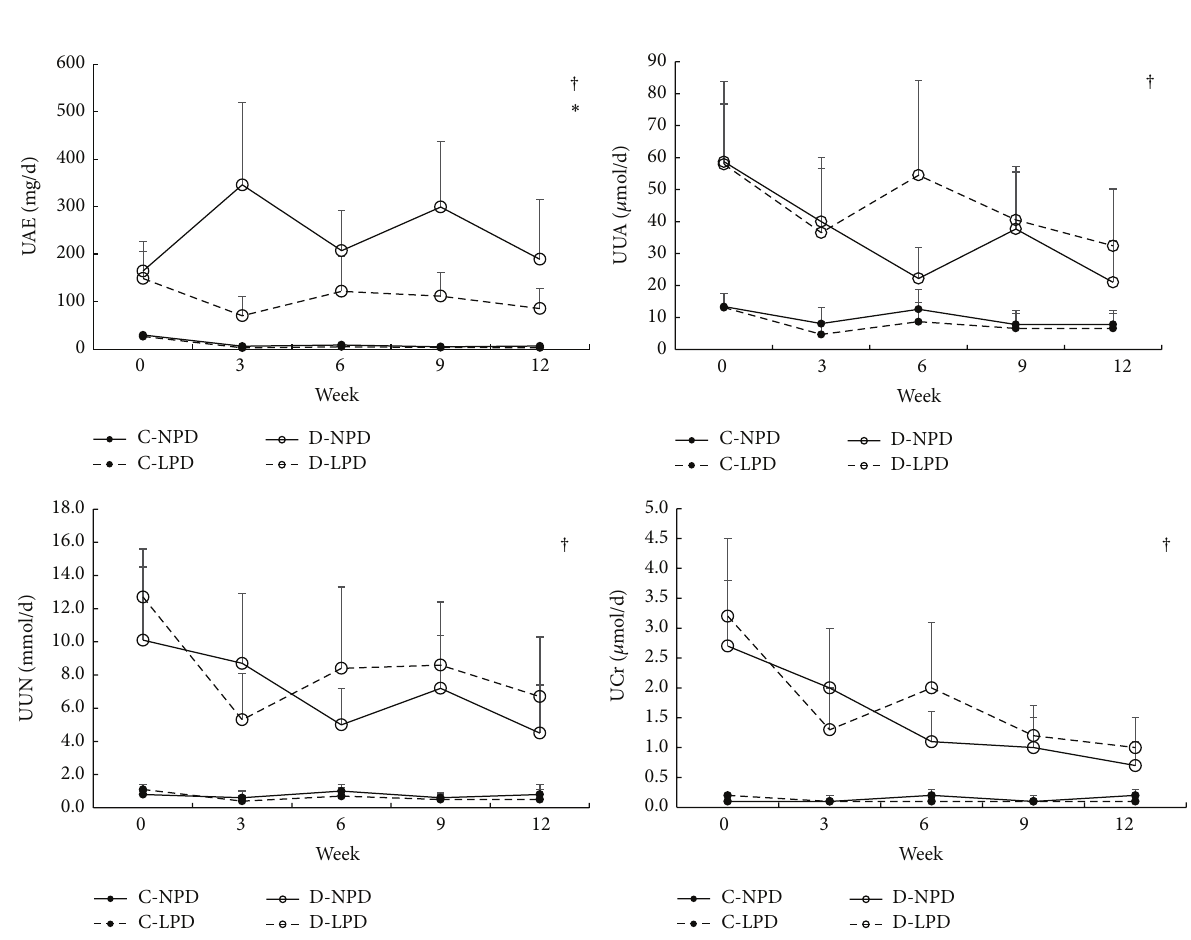
Figure 4: Time course of 24 h urinary excretions among different rat groups. Solid circle with solid and dashed lines represents C-NPD and C-LPD group, respectively, while hollow circle with solid and dashed lines shows data of D-NPD and D-LPD group, respectively. Data were expressed as mean ± SD. † 𝑃 < 0.05 for D-LPD versus C-NPD rats, ∗ 𝑃 < 0.05 for D-NPD versus D-LPD group in the global trend comparisons. UAE: urinary albumin excretion, UUA: urinary uric acid, UUN: urinary urea nitrogen, UCr: urinary